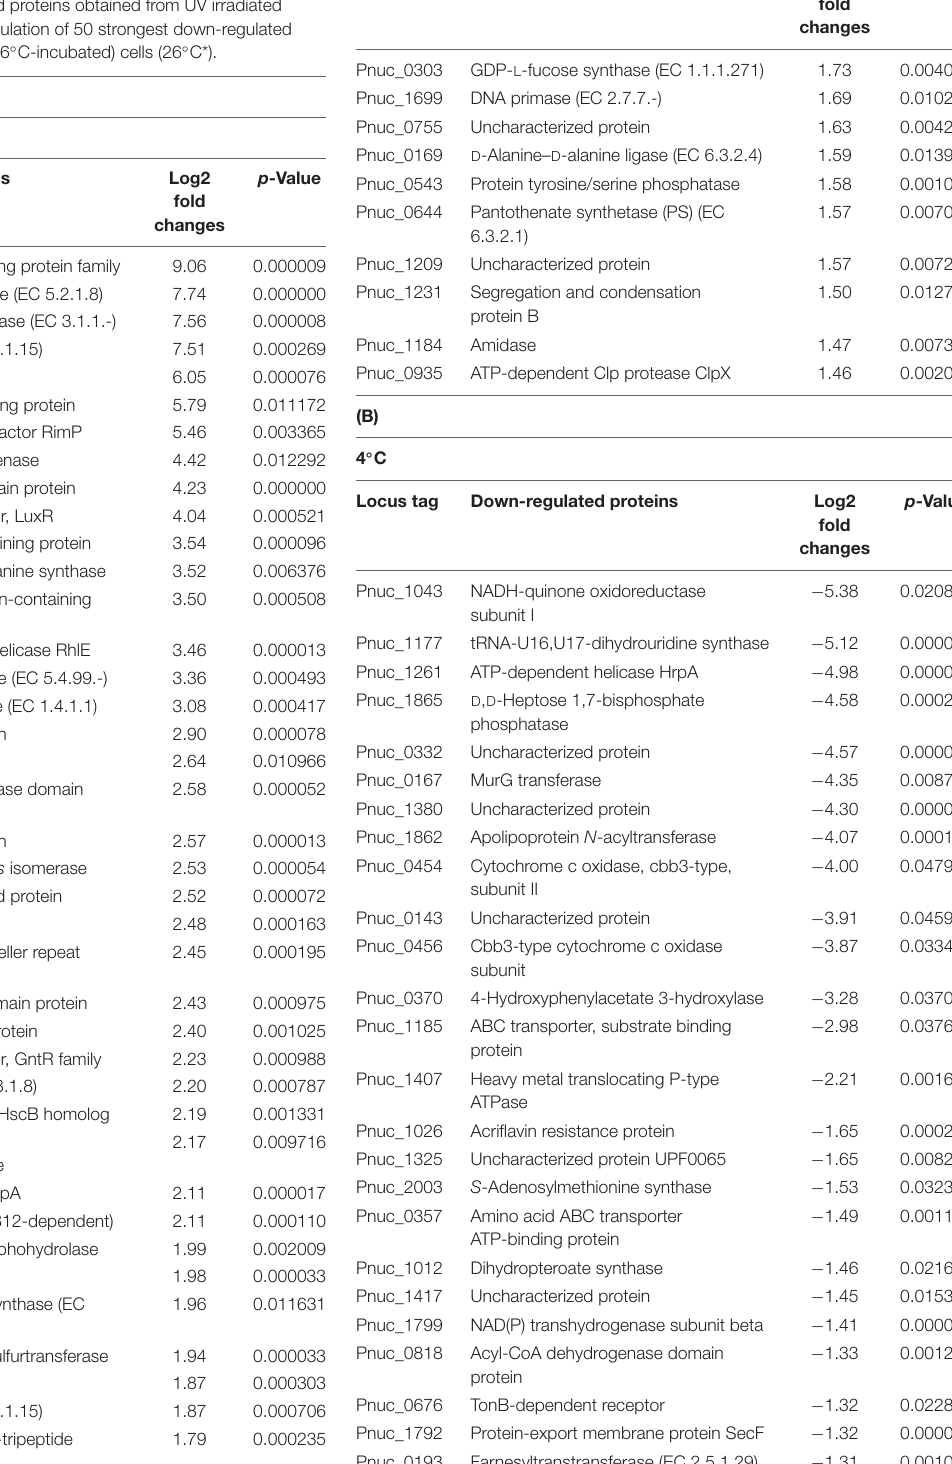
TABLE 1 | Quantitative proteome analysis. (A) Tabulation of 50 strongest up-regulated proteins obtained from 4 ◦ C-incubated cells. (B) Tabulation of 50 strongest down-regulated proteins obtained from 4 ◦ C-incubated cells. (C) Tabulation of 50 strongest up-regulated proteins obtained from UV irradiated (26 ◦ C-incubated) cells (26 ◦ C*). (D) Tabulation of 50 strongest down-regulated proteins obtained from UV irradiated (26 ◦ C-incubated) cells (26 ◦